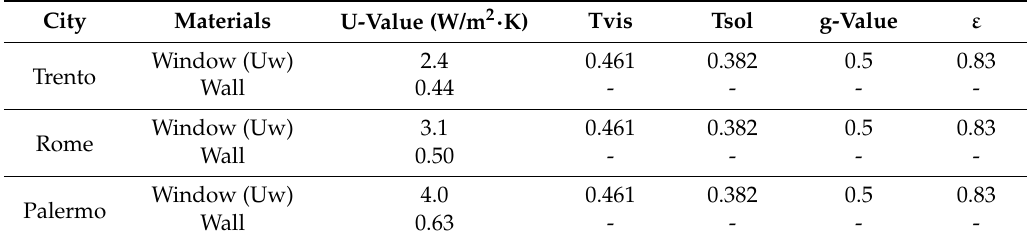
Table 4. Thermal and optical proprieties of the double ‐ glazed element and wall (STD).